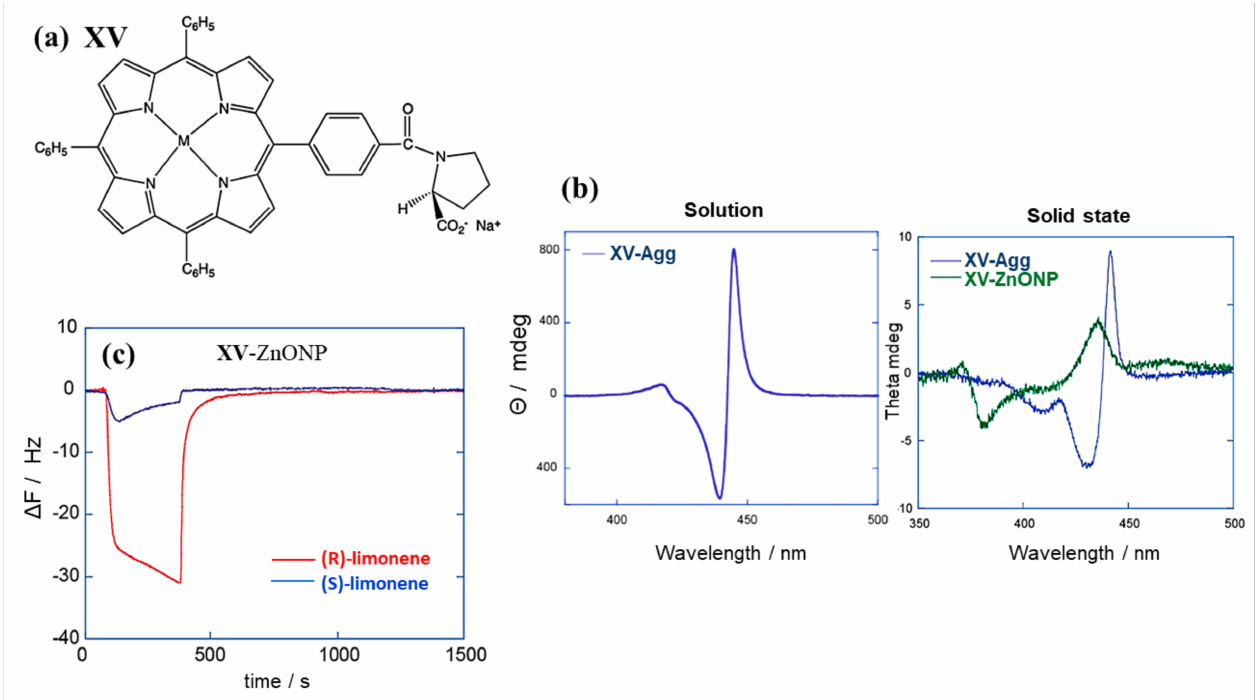
Figure 12. ( a ) Structure of the chiral Zn(II)-porphyrin XV (M = Zn); ( b ) CD-spectra of XV -aggregates in ethanol/water (on the left), CD-spectra respectively of XV -aggregates (blue line) and XV -ZnONP (green line) deposited on glass slide; ( c ) Dynamic of response of XV -ZnONP sensors to 160 ppm of (R)- and (S)-limonene. Adapted with permission from reference [70]; published by American Chemical Society